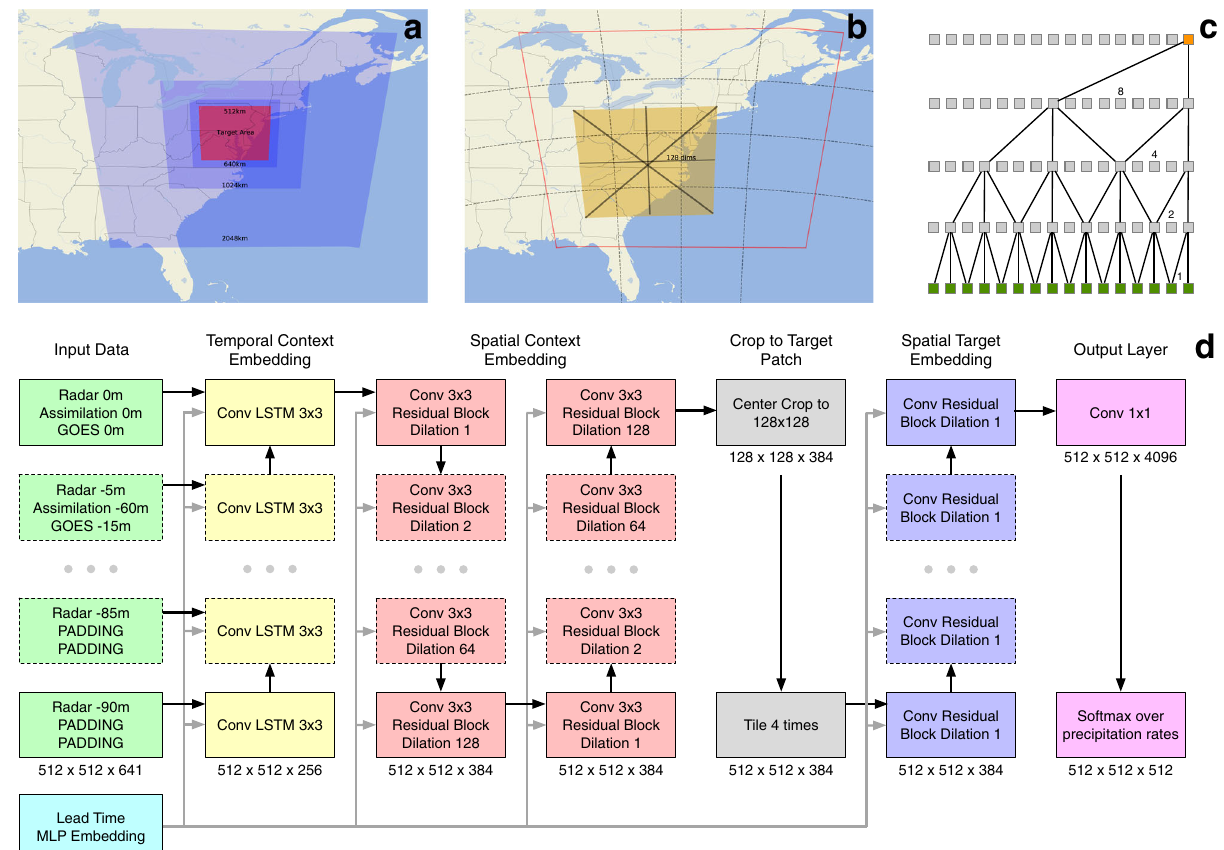
Fig. 9 | MetNet-2 context aggregation and architecture. Diagrams of various aspects of the MetNet-2 model. a MetNet-2 captures increasing amounts of context around the target patch. The fi gure shows the effects of the ortho- graphic projection for the context and target, onto Earth with an equir- ectangular projection. b MetNet-2 layers are spread over 4×4 TPU cores. The fi gure represents a convolution with dilation factor 128 reaching out to neigh- boring TPUs to retrieve the relevant parts of the layer. c Pattern of connectivity when using convolutions with dilation factors that double at each layer. The total receptive fi eld grows exponentially in the number of layers. d